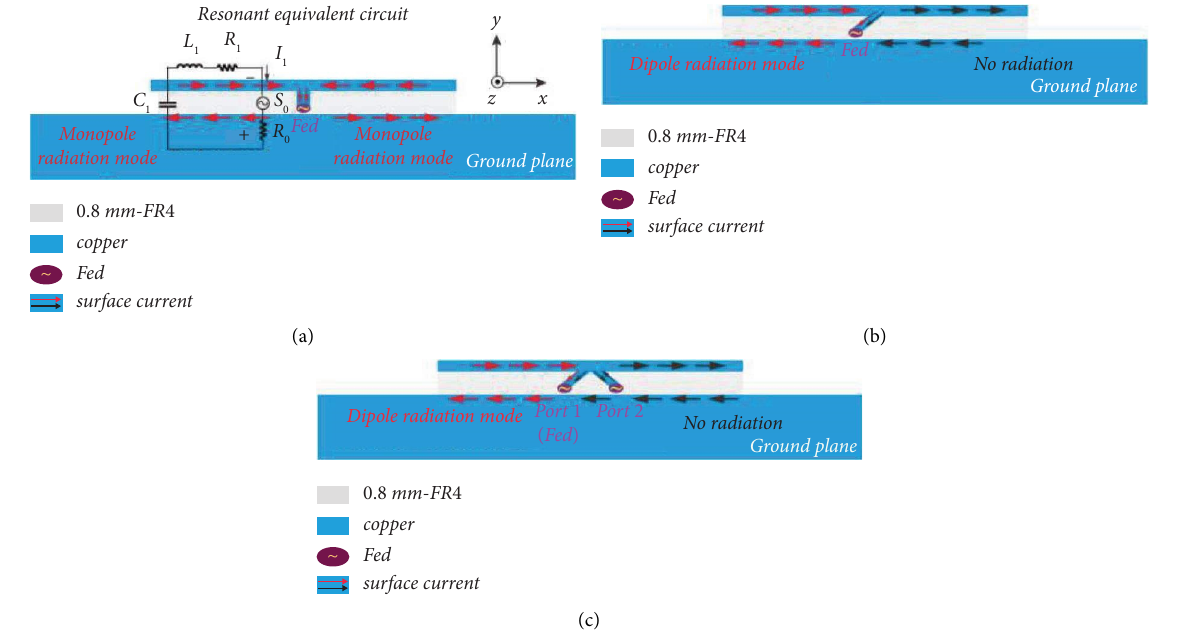
Figure 1: Current distribution of. (a) Te single-port T -shaped antenna A . (b) Te single-port deformed T -shaped antenna B with oblique microstrip. (c) Te dual-port deformed T -shaped antenna C with two oblique microstrips excited by port 1 (unit: mm).